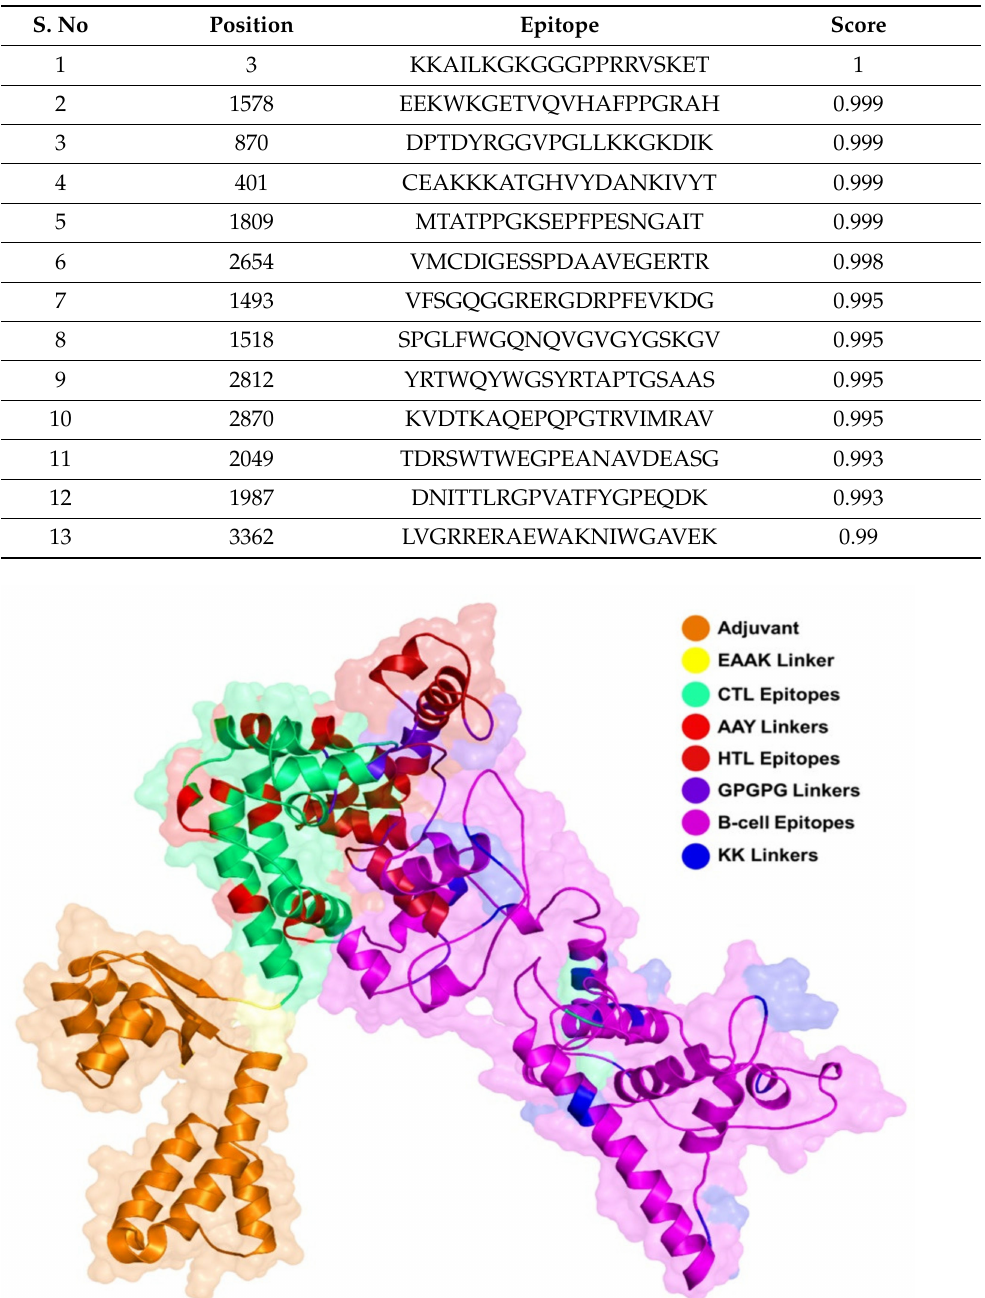
Table 3. Predicted linear B-cell epitopes for the virus polypeptide. The predicted score for each peptide is given against each B-Cell epitope.